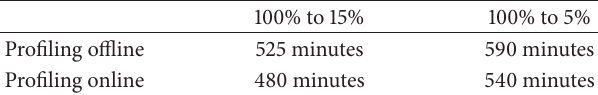
Table 3: Battery endurance